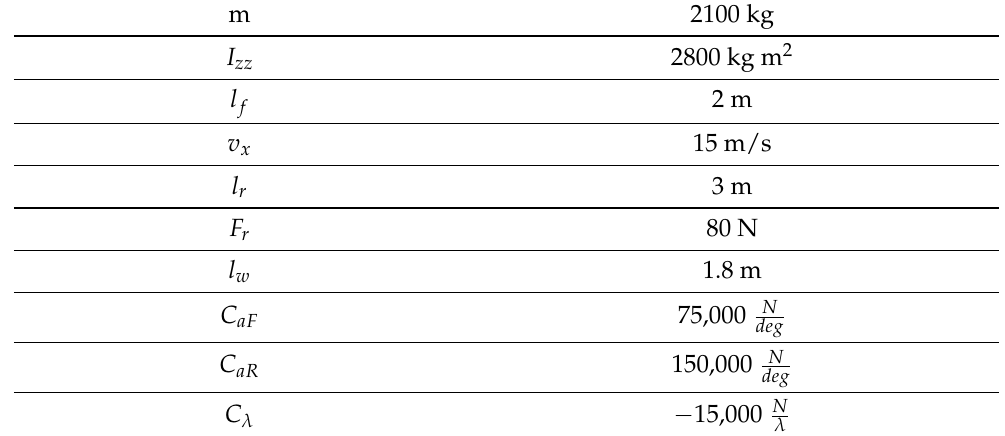
Table 3. Vehicle constants.